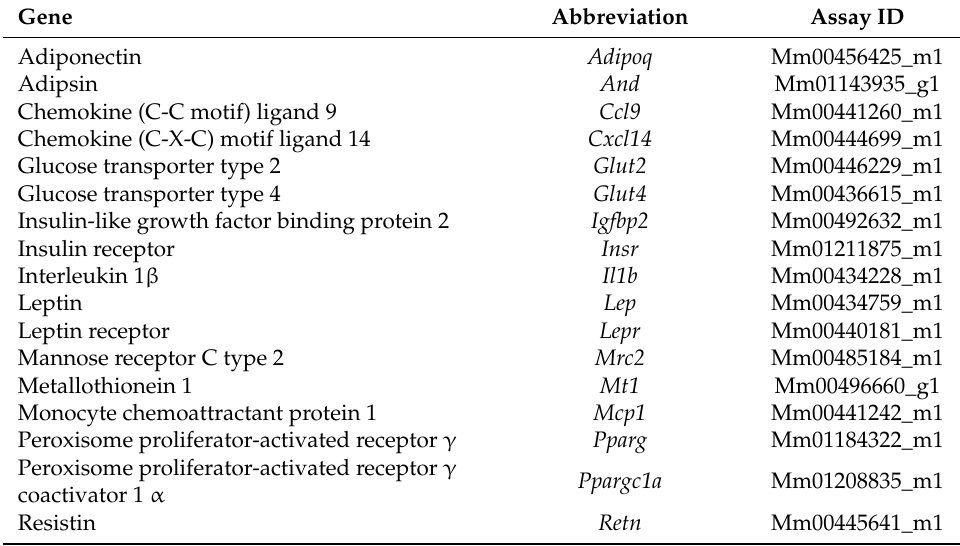
Table 2. TaqMan Gene Expression